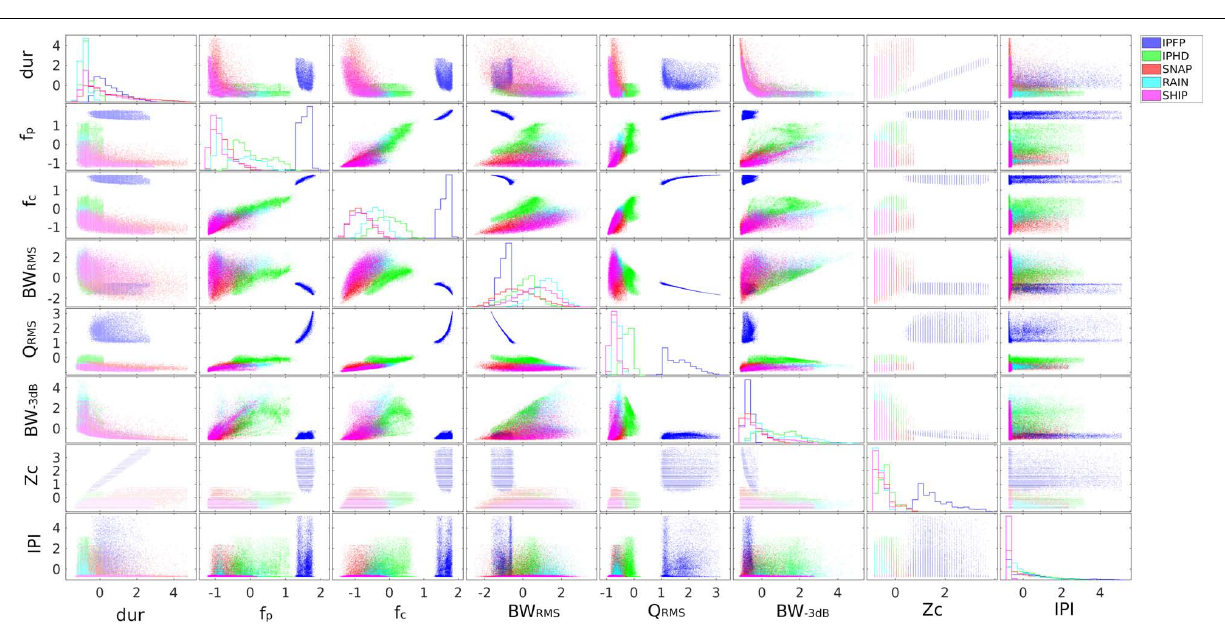
FIGURE 3 | Training data exploration. Series of scatter plots of the training dataset after standardization. The data have been grouped according to the five classes selected (IPFP, IPHD, SNAP, RAIN, SHIP). Each individual set of axes contains a scatter plot of a column of x against another column of x. In the diagonal, graphs of the contours of the grouped histograms (similar to Figure 2 but with standardized